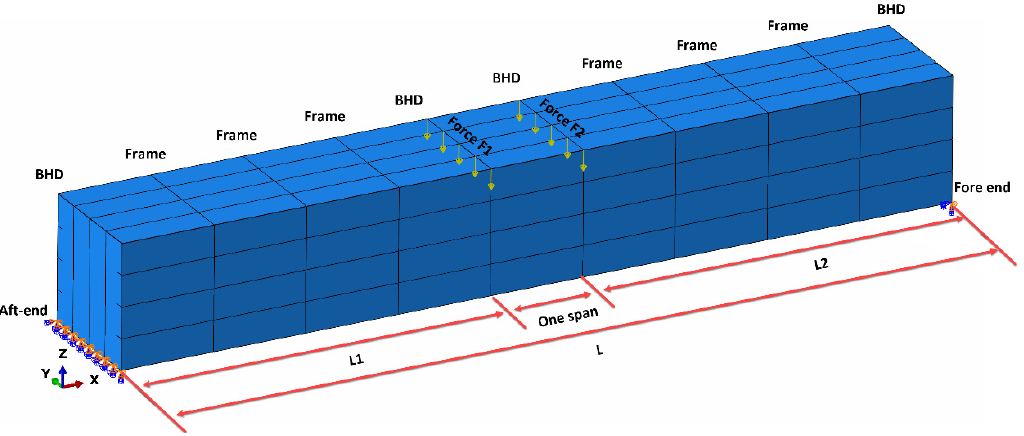
Figure 3. Boundary conditions of box girder.